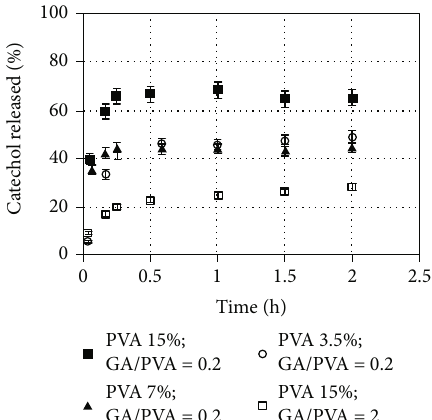
Figure 64: Catechol release as a function of time from PVA particles produced by membrane emulsi fi cation (ME), with di ff erent PVA concentration (3.5, 7, and 15wt.%) and GA:PVA ratio (0.2 and 2) [171].